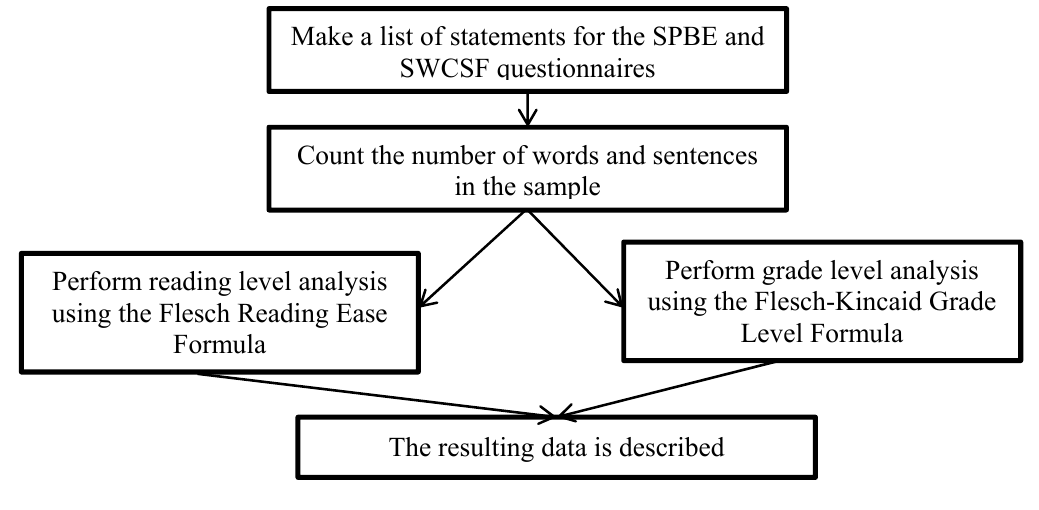
Figure 1. Data Analysis